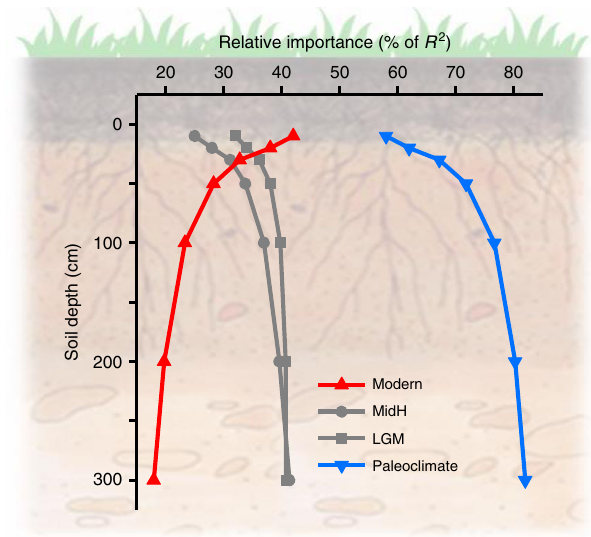
Fig. 3 Standardized relative importance of paleo- and modern climate for the spatial pattern of soil carbon stock over the permafrost regions on the Tibetan Plateau at various soil depths. The relative importance was determined by the Lindeman – Merenda – Gold method 60 . Note that the relative importance of paleoclimate (blue curve) is the sum of the values of LGM and MidH (grey curves) by